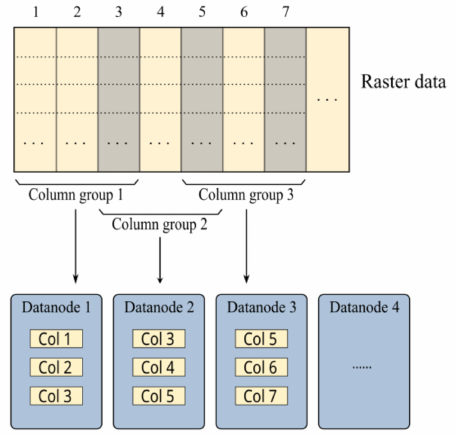
Figure 2. Example of the column-based group method for 2D raster data. Data are first divided into many grid files, files in every three columns are assigned to a column group, and one replica set of these files is placed on a datanode. “Col 1” in figure represents all grid files in the first